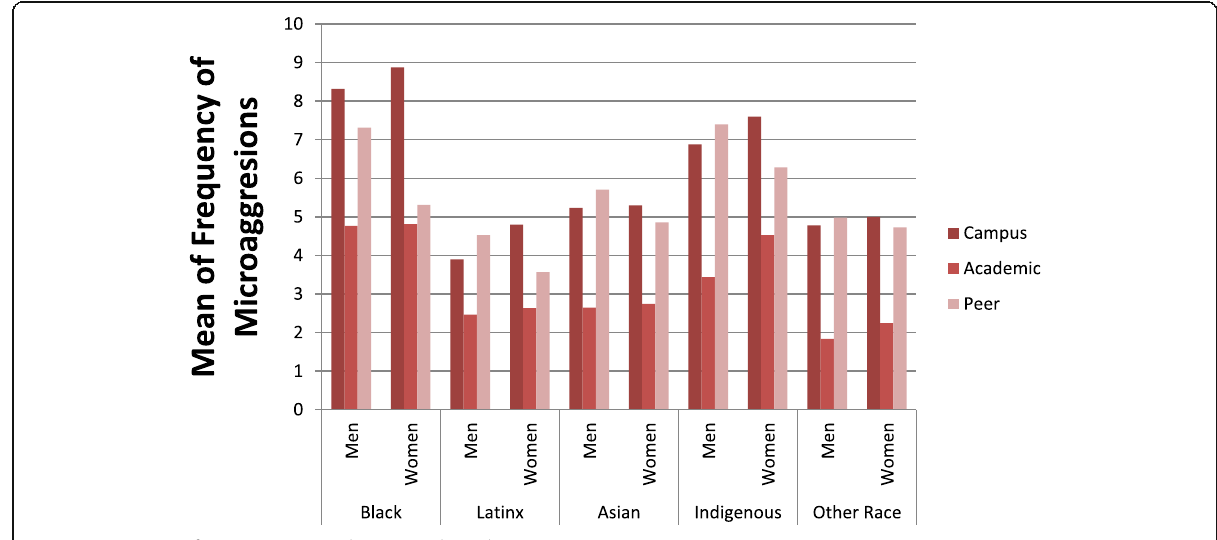
Fig. 2 Experiences of microaggressions by race and gender